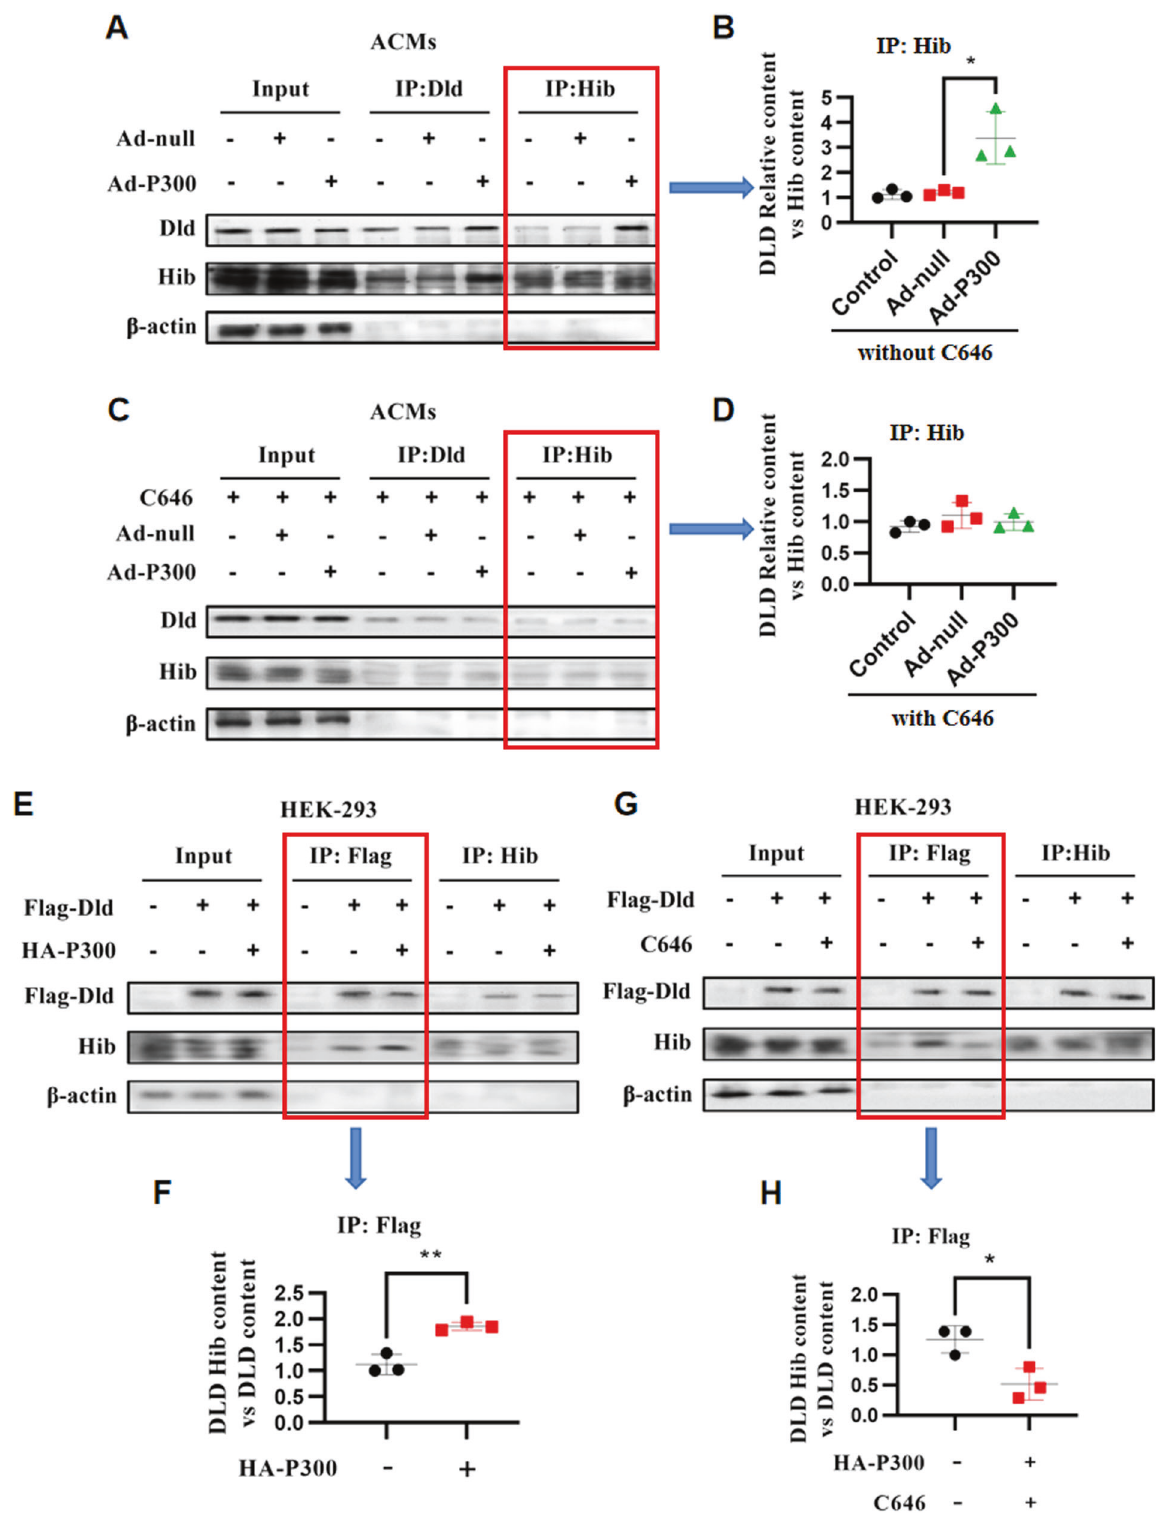
Fig. 5 P300 mediates DLD 2-hydroxyisobutyrylation. A , B ACMs cells were transfected with or without P300 plasmid and harvested for immunoprecipitation and immunoblot analysis with the indicated antibodies, n = 3 for each group. C , D After treatment with P300 inhibitor C646, ACMs cells were transfected with or without P300 plasmid and harvested for immunoprecipitation and immunoblot analysis with the indicated antibodies, n = 3 for each group. E , F HEK293 cells were transfected with or without P300 plasmid and harvested for immunoprecipitation and immunoblot analysis with the indicated antibodies, n = 3 for each group. G , H After treatment with C646, HEK293 cells were transfected with or without P300 plasmid and harvested for immunoprecipitation and immunoblot analysis with the indicated antibodies, n = 3 for each group. The data were analyzed using Kruskal – Wallis test and were expressed as means ± SD, * p <